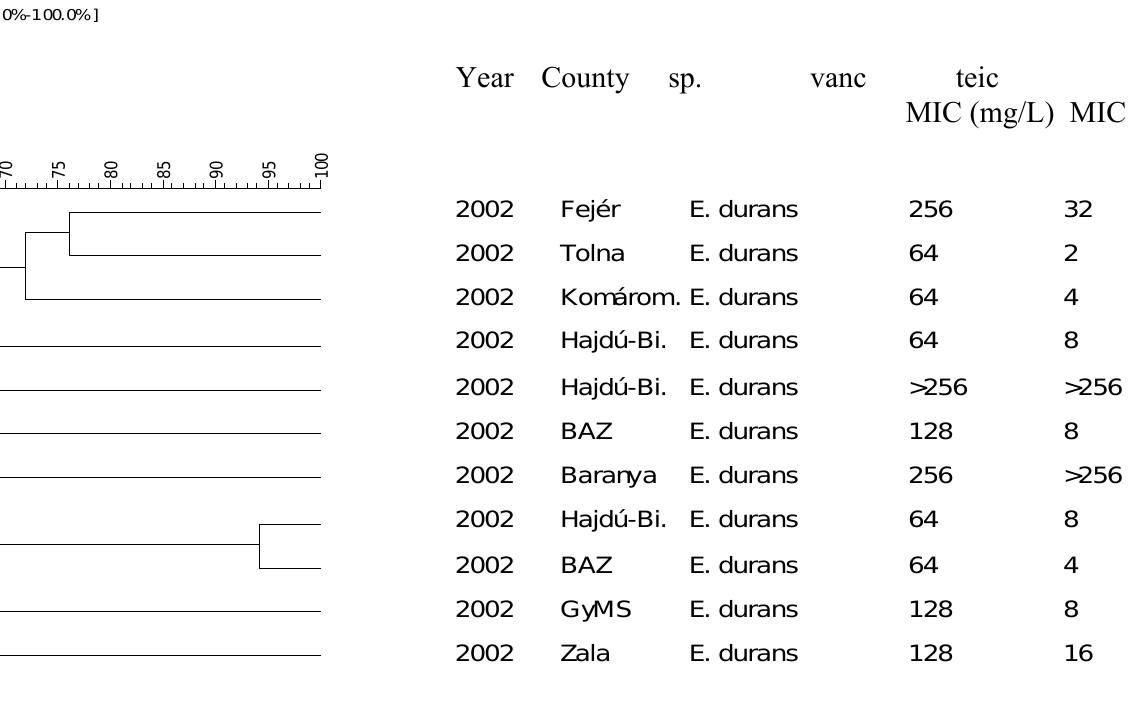
Figure 19. Dendrogram of vancomycin-resistant E. durans strains isolated from chicken in